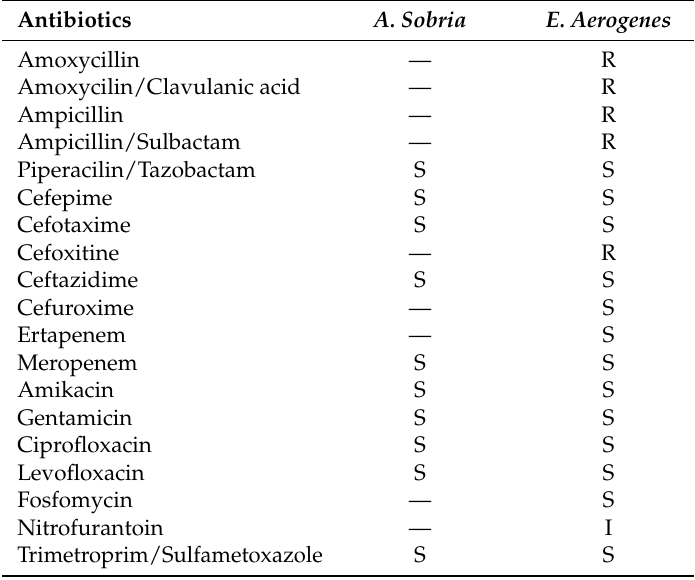
Table 2. Antibiotic susceptibility of bacterial isolates identified from water in ornamental fountain (L4) in